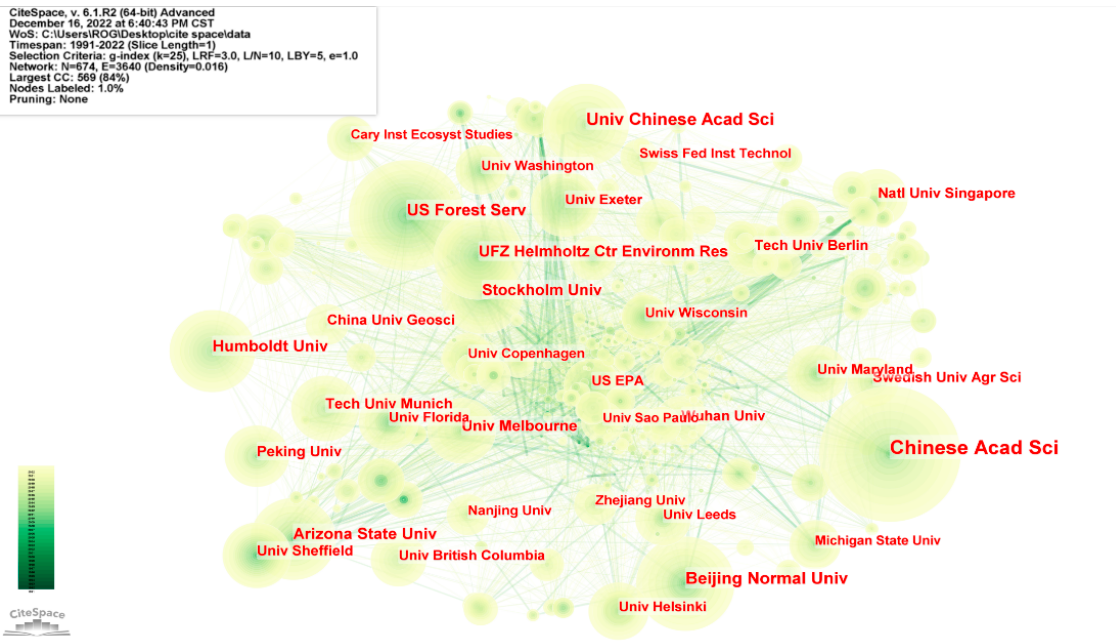
Figure 6. Knowledge map of cooperative institutions in the research on UES during 1991–2022.